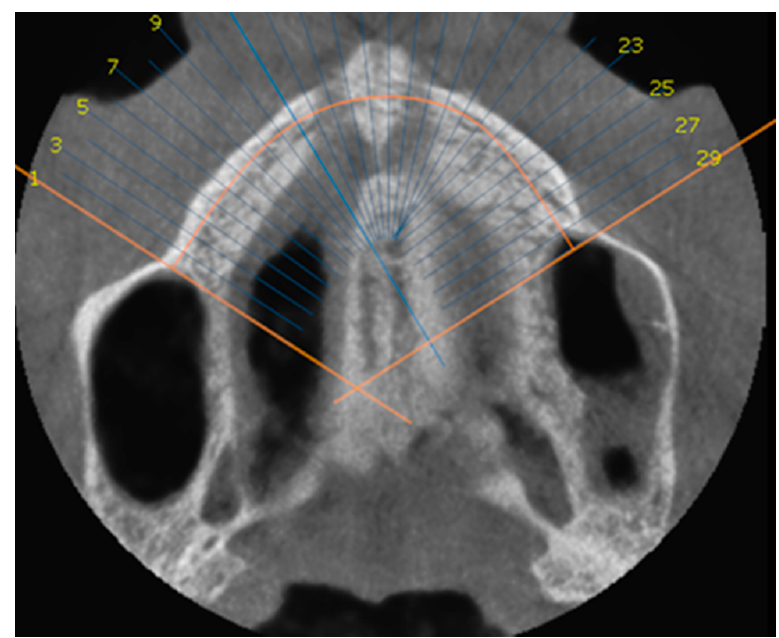
Figure 2. Stage E palatal suture as classified by Angelieri et al.